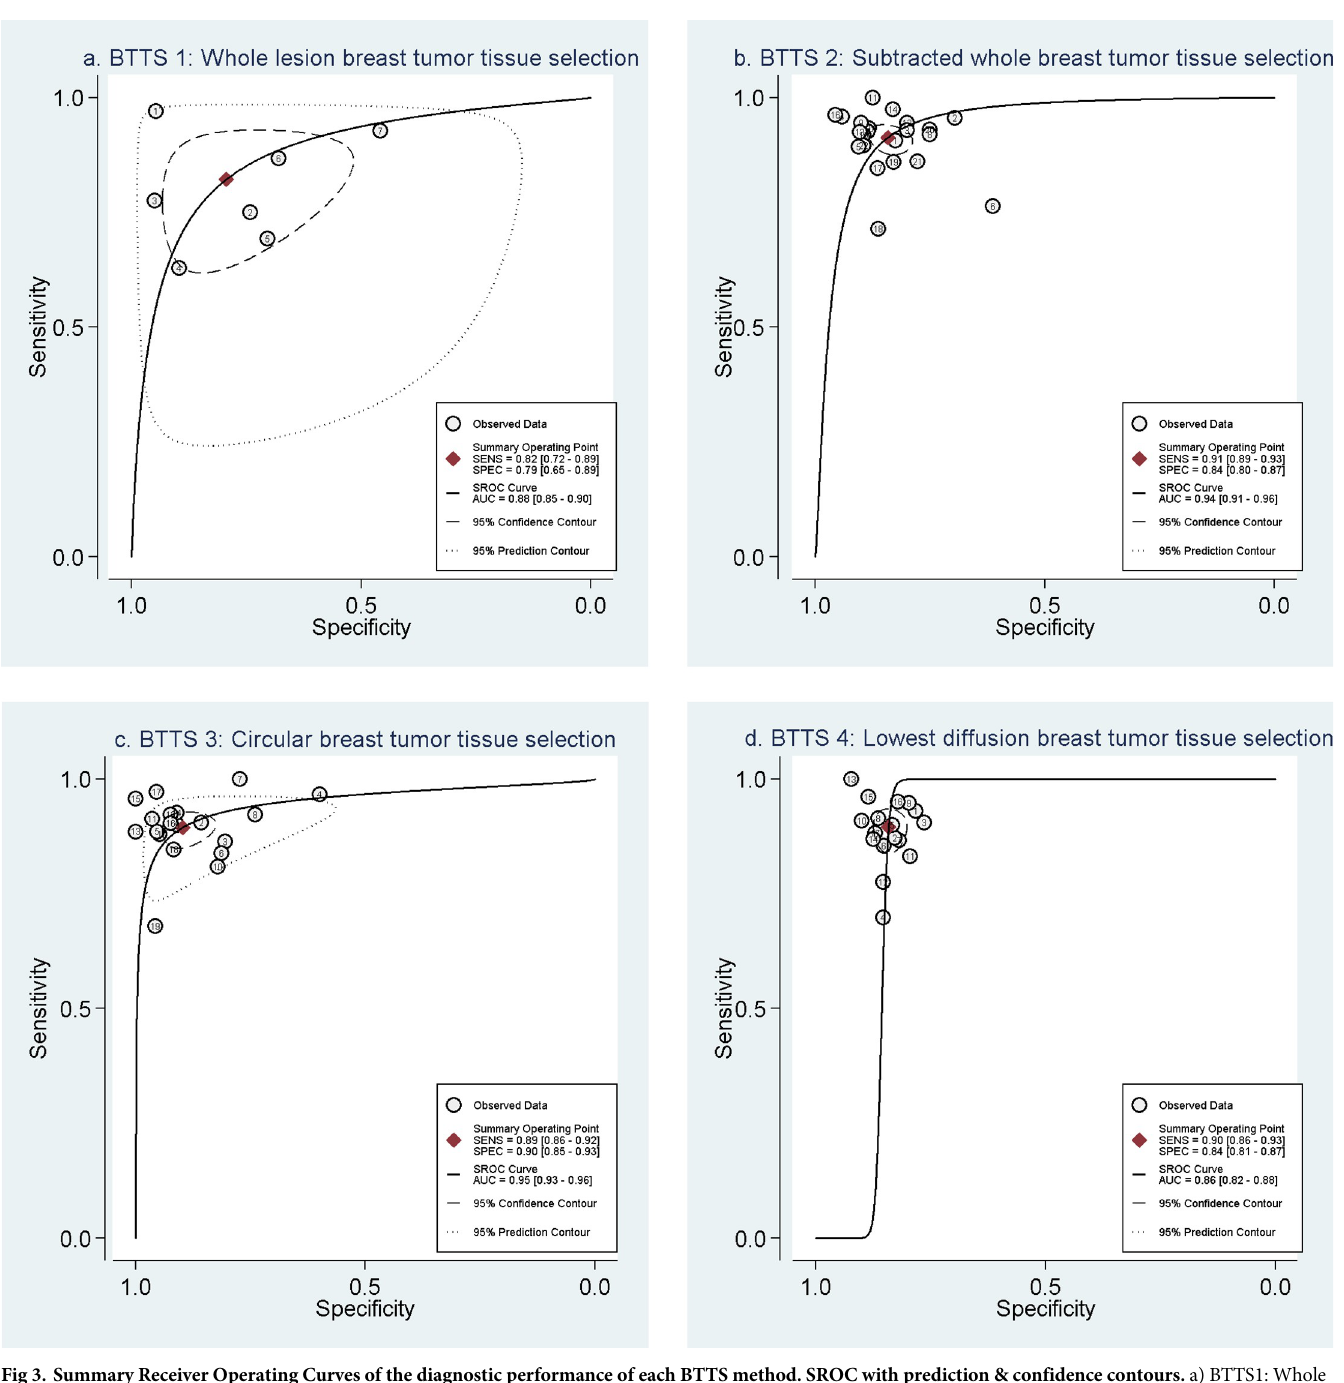
Fig 3. Summary Receiver Operating Curves of the diagnostic performance of each BTTS method. SROC with prediction & confidence contours. a) BTTS1: Whole breast tumor tissue selection, b) BTTS2: Subtracted whole breast tumor tissue selection, c) BTTS3: Circular breast tumor tissue selection, d) BTTS4: Lowest diffusion breast tissue selection. BTTS = breast tumor tissue selection, SROC = summarized receiver operator characteristic, AUC = area under the SROC curve, SENS = sensitivity, SPEC = specificity.